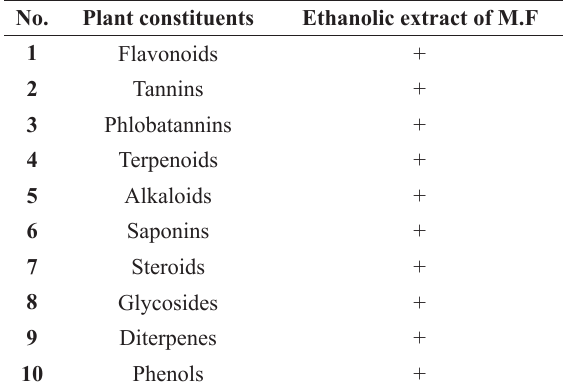
Phytochemical screening of the ethanolic extract of Myristica fragrans (M.F).